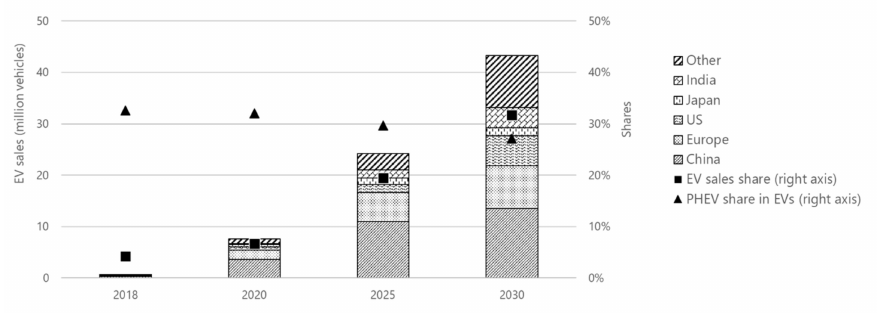
Figure 2. Global future trends of EV popularization for road EVs